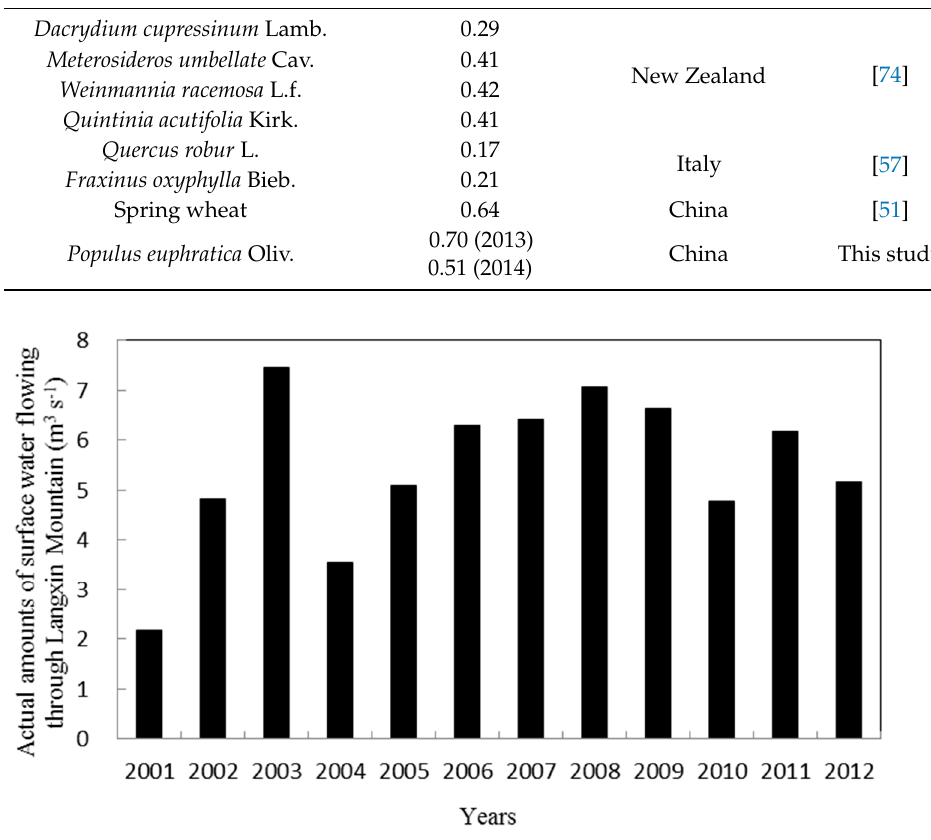
Figure 8. Actual amounts of surface water flowing through Langxin Mountain beginning from the initiation of Ecological Water Diversion Project (2001–2012).